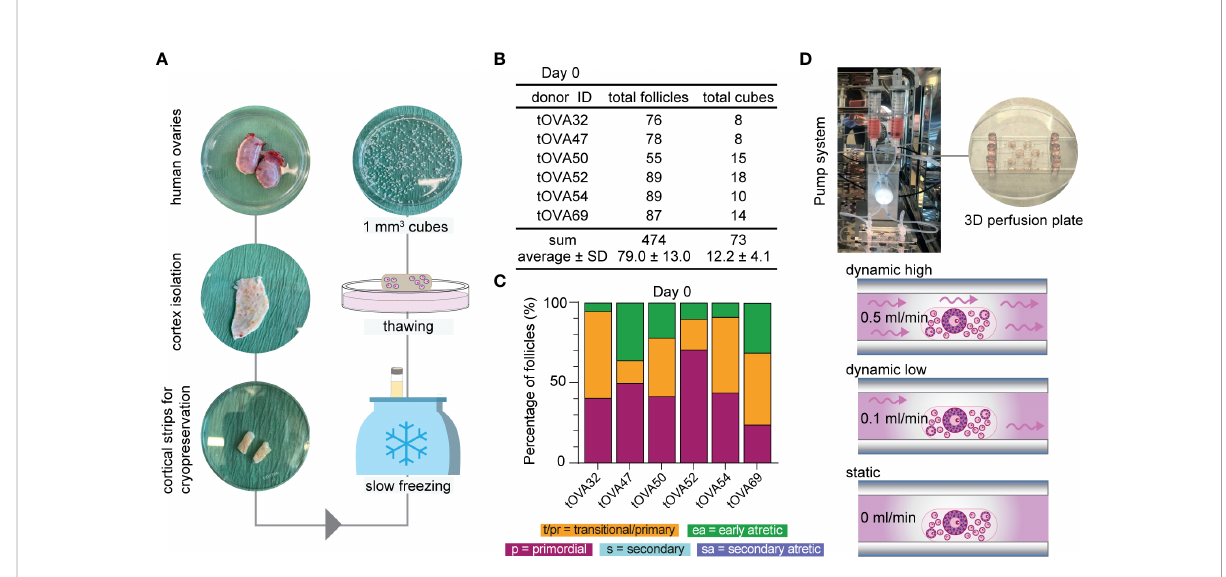
FIGURE 2 Study design and follicular distribution at D0. (A) Schematic work fl ow from collection until culture. Upon arrival, the ovaries were bisected and the outer cortex was isolated by scraping the medulla and inner cortex. Cortical strips were prepared for cryopreservation using slow freezing. Thawed-cortical tissue was cut into approximately 1mm3 cubes to fi x or culture. (B) Total number of follicles and cubes analyzed per donor at D0, sum and average ± standard deviation (SD). (C) Follicular distribution per donor at D0. (D) Ovarian cortical cubes were placed in microwells (1-2/well) from m -slide III 3D perfusion plates. Microchannels were fi lled with culture medium and plates were either connected to the perfusion pump for dynamic culture applying high fl ow rate (0.5ml/min), low fl ow rate (0.1ml/min) or no fl ow